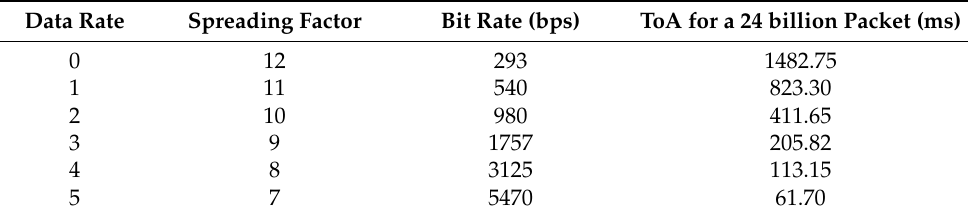
Table 1. Data Rate configuration for a 125 kHz bandwidth in the EU868 ISM